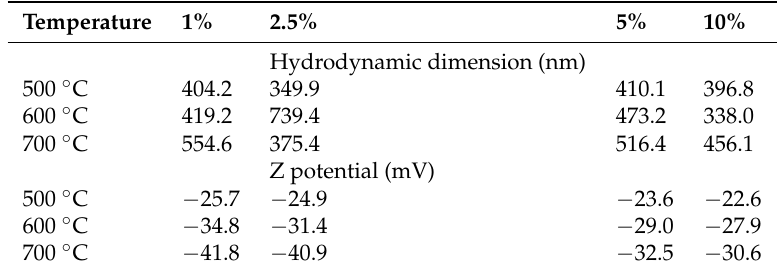
Figure 9. Photoluminescence (PL) spectra of Mn-doped Nb 2 O 5 powders at different Mn concentration annealed 700 ◦ C. Table 3. Hydrodynamic stability parameters of samples subjected to 700 ◦ C for all samples with the addition of